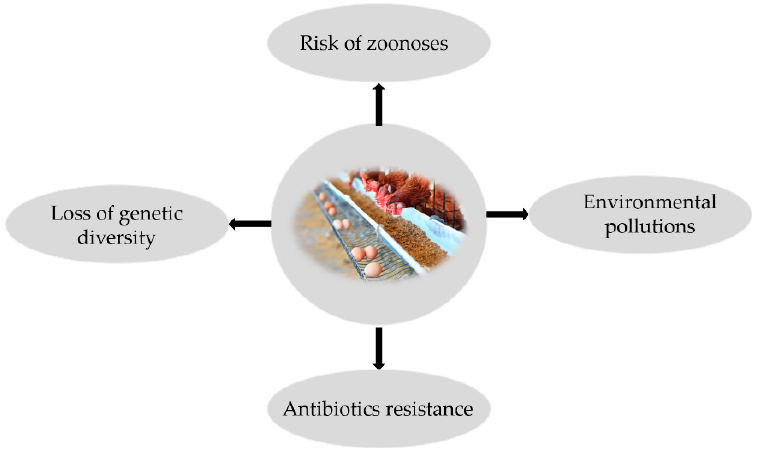
Figure 2. Disadvantages of commercial farming of livestock .